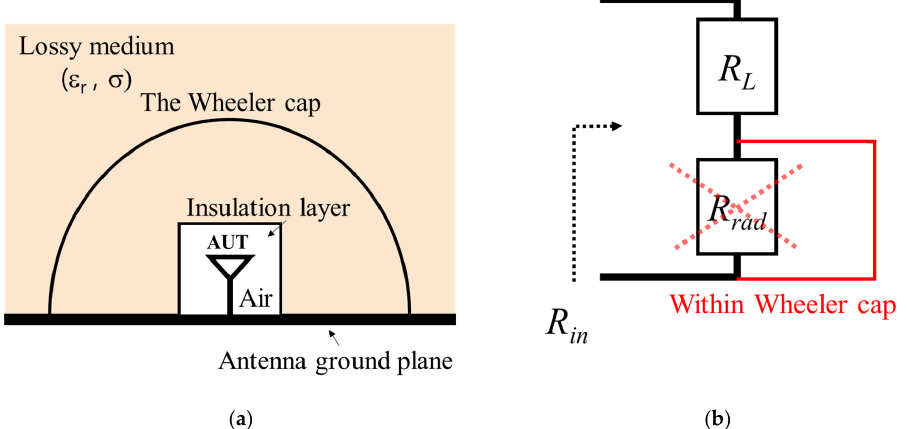
Figure 3. ( a ) Structure of the antenna isolated from the lossy medium by the insulating layer and the Wheeler cap. ( b ) Equivalent circuit model of antenna within the Wheeler cap.